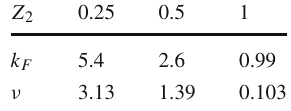
( a ) ν vs. 1 /ρ for q = 2 and T =0. (b) Fig. 7 Blue, brown and purple curve represents Z 2 = 1, 0.5 and 0.25 respectively. Left: Red and green dashed line correspond to ν = 1 / 2 and ν = 1 line respectively. Right: Black dashed line correspond to ρ = 0 . 91 Table 1 Fermi momenta k F Z 2 0.25 0.5 1 and ν for different values of f parameter Z 2 with q = 2 and k F 5.4 2.6 0.99 ρ = 0 . 91 ν 3.13 1.39